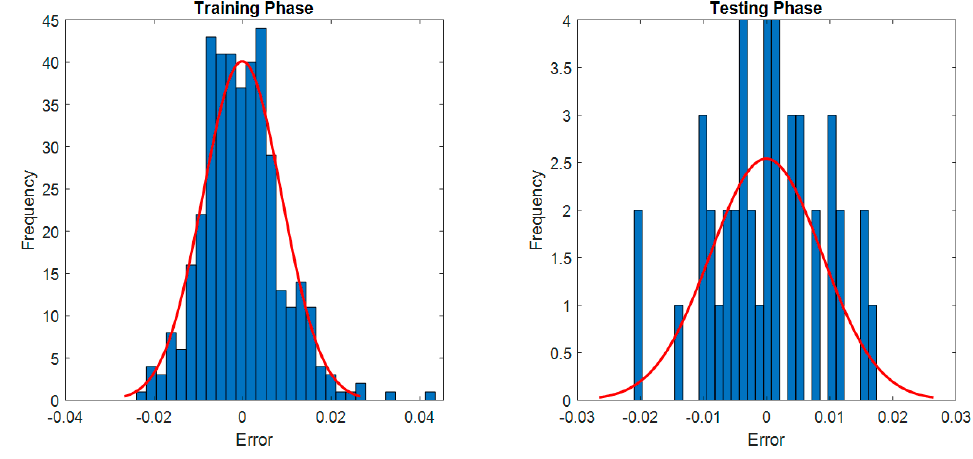
Figure 10. The error distribution of ABC-LM-ANN.